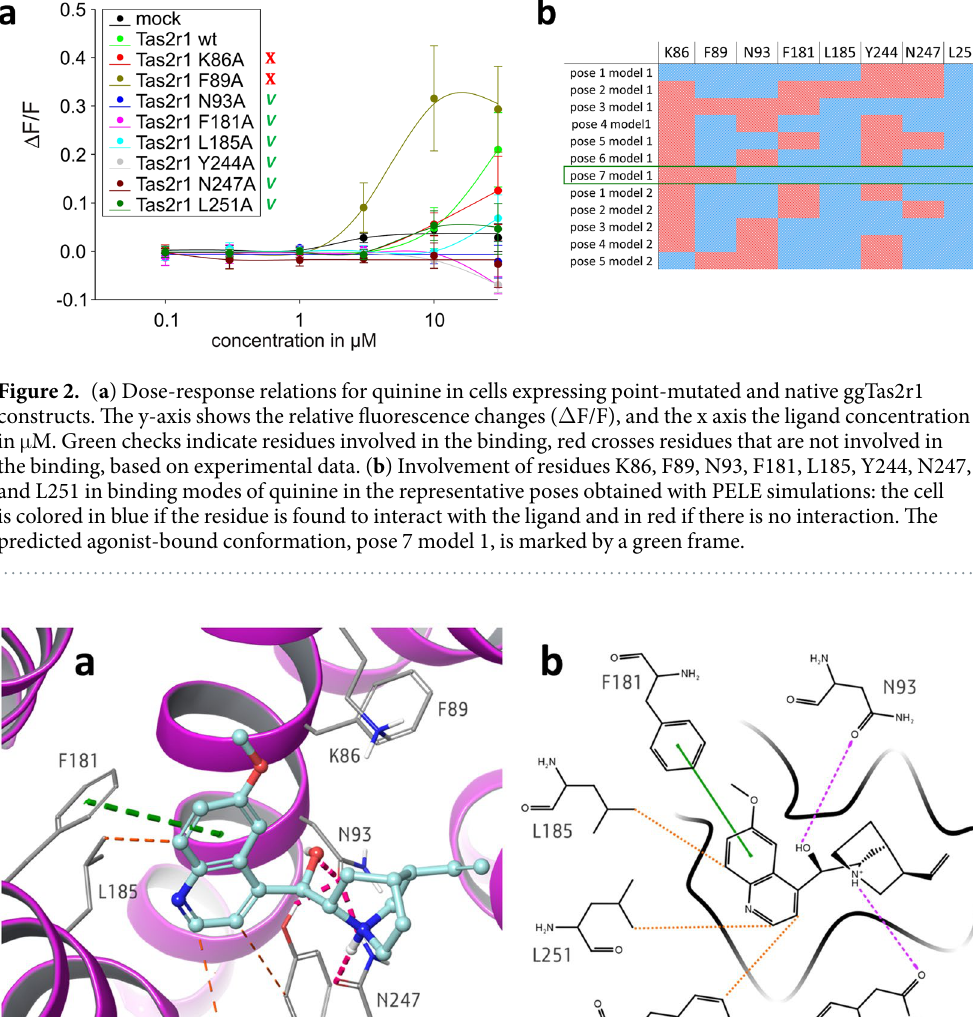
approach allowing for flexibility of binding site residues during docking (Fig. 1, step 3): PELE (Protein Energy Landscape Exploration) server (https://pele.bsc.es/pele.wt), a stochastic method of mapping large conformational rearrangements and Induced-Fit events in protein-ligand interactions 33–36 . We used the “Ligand binding refine- ment” protocol available in PELE to include flexibility of the ggTas2r1 binding site residues in complex with qui- nine. These simulations produce almost 5000 binding poses for each model, allowing an extended analysis of the possible binding modes of quinine in the ggTas2r1 receptor. The structures were clustered into 7 representative structures for model 1, and 5 for model 2 (Fig. 1, step 4). The quinine molecule reaches the same location in all representative complexes. Examples showing how the binding pocket changes after refinement in each model are shown in Supplementary Figure S4. The ligand-binding refinement leads to a slight increase in the binding site of model 1 and a slight decrease in that of model 2, resulting in similar sizes and residue arrangements of refined binding site. Consequently, the calculated SiteMap descriptors are very similar among the poses generated by the two models. SiteMap descriptors before PELE simulations and average values of 7 poses’ SiteMap descriptors (descriptors for single representative poses are found in Supplementary Tables S1 and S2) after PELE simulations are reported for each model in Table 1. Examination of the poses suggests that residues K86, F89, N93, F181, L185, Y244, N247, and L251, corre- sponding to Ballesteros-Weinstein (BW) 47 numbers 3.29, 3.32, 3.36, 5.38, 5.42, 6.47, 6.51, 6.55, respectively, are